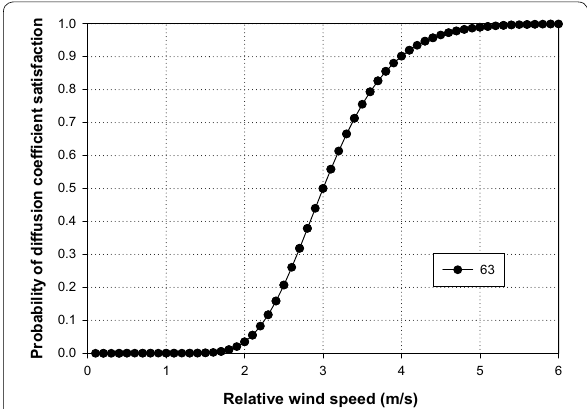
Fig. 11 Satisfaction Curve of wind speed parameter for chloride diffusion coefficient rate